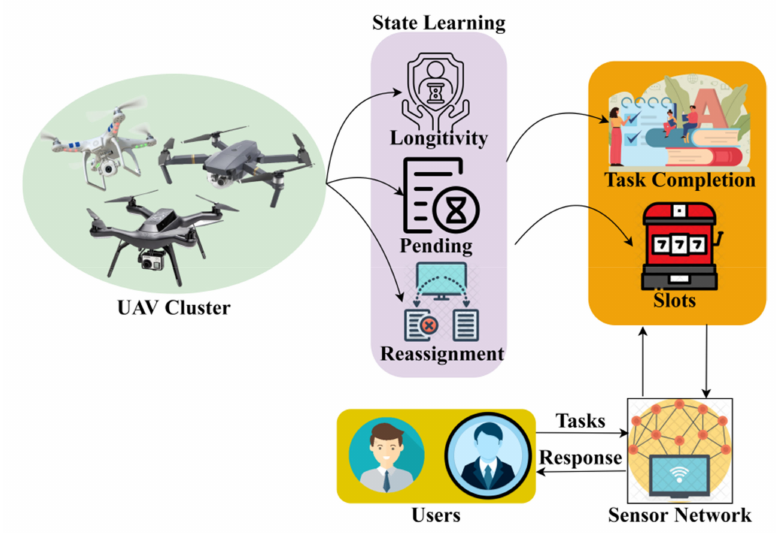
Figure 1. RCM-IE (Rational Clustering Method using Information